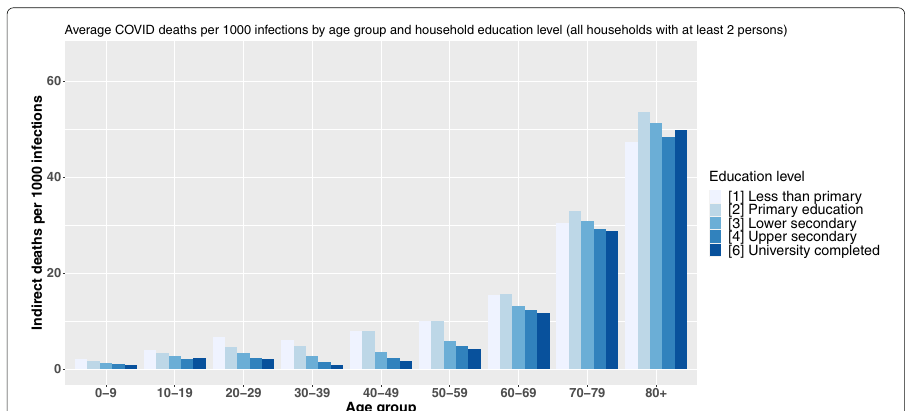
Fig. 9 Average COVID-19 deaths per 1000 infections by age group and head-of-household education level (2+